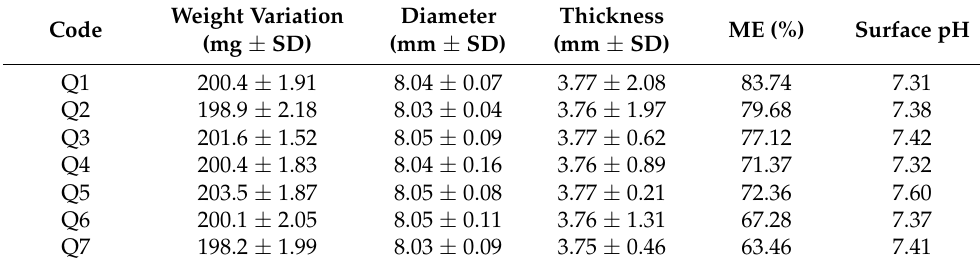
Figure 3. Comparison of the physical parameters of buccal formulations. Table 2. Physical characterization of mucoadhesive tablets.